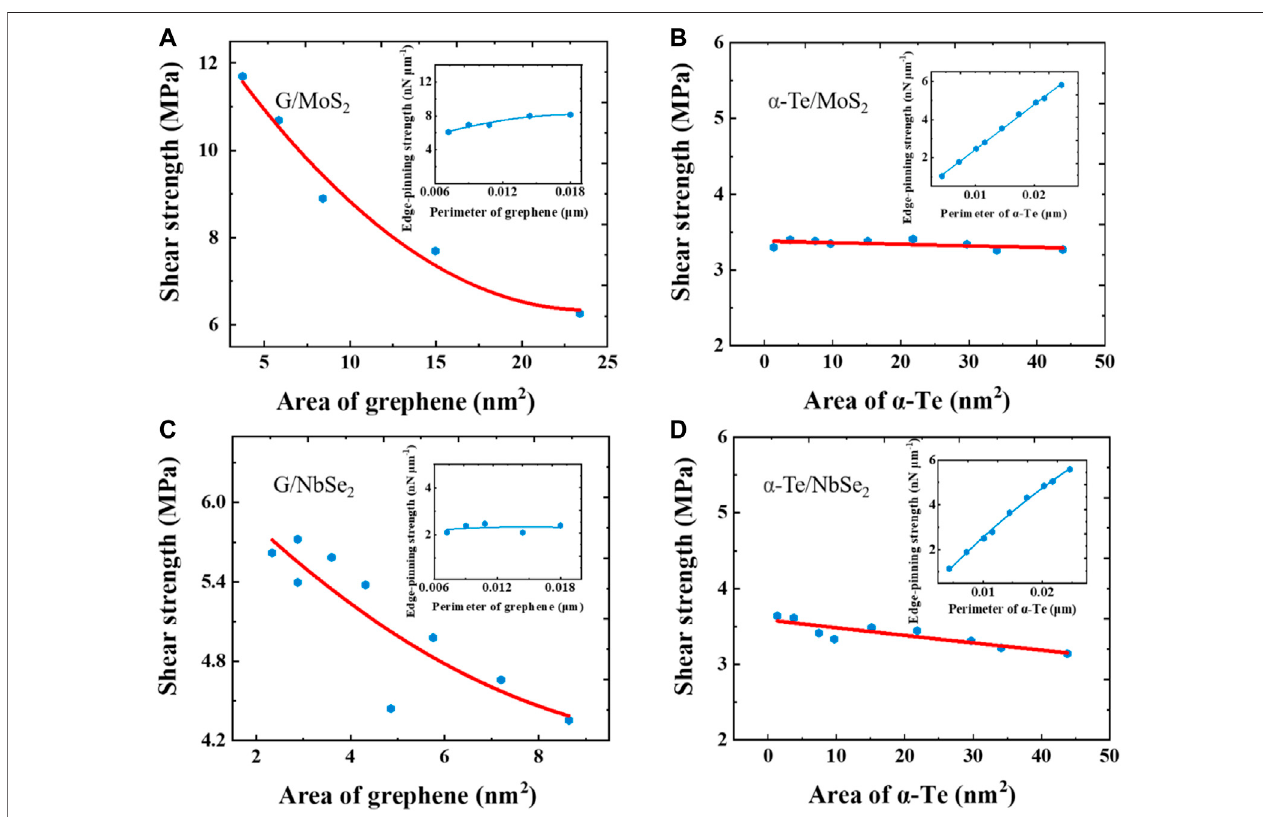
FIGURE 9 | Shear strength and edge-pinning strength for different heterostructures. (A) Graphene/MoS 2 ; (B) α -Te/MoS 2 ; (C) Graphene/NbSe 2 ; (D) α -Te/NbSe 2 . Theinsetshowsthecorrespondingedgepinningstrengthtrendwiththedomainperimeter.Thesolidlinesinthe fi guresareobtainedbyleastsquares fi ttingbasedonthe data points.